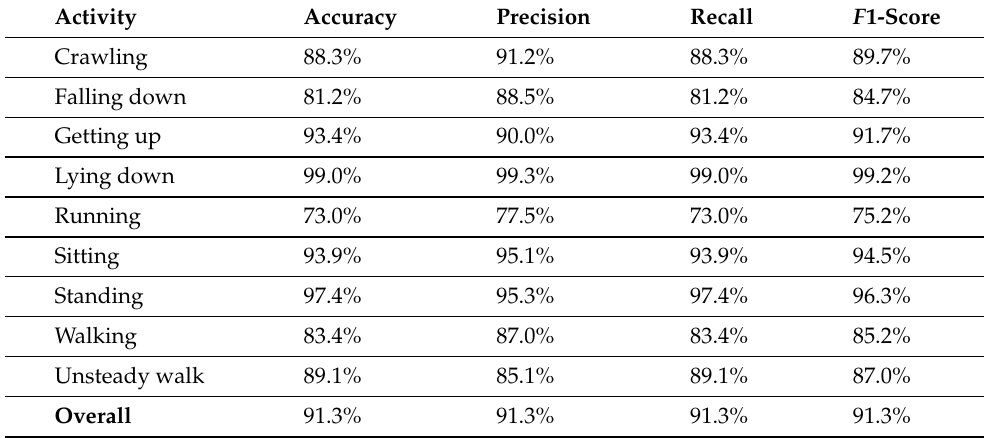
Table 6. Classification results for the activity detection on the test set.